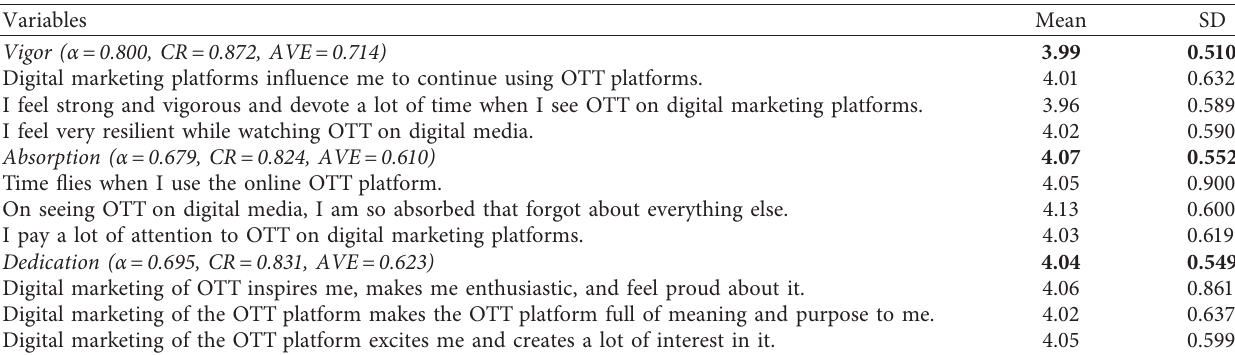
Table 5: Consumer engagement: descriptive statistics.